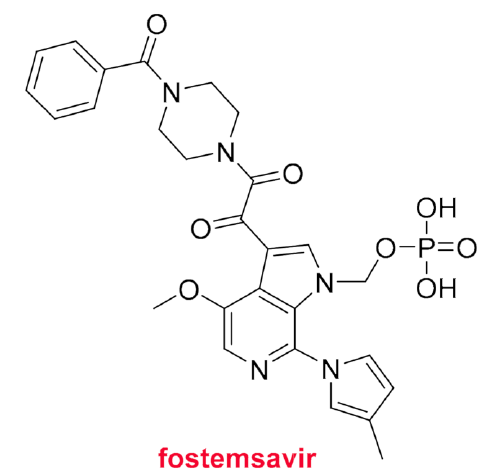
Figure 10. Structure of